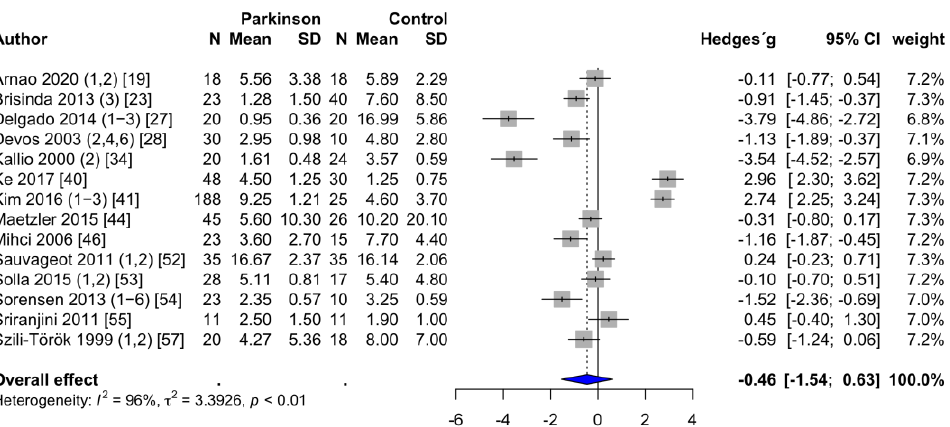
Figure 5. Forest plot pNN50, random-effects meta-analysis. pNN50: Percentage of adjacent normal heartbeat intervals that differ from each other by more than 50 ms.